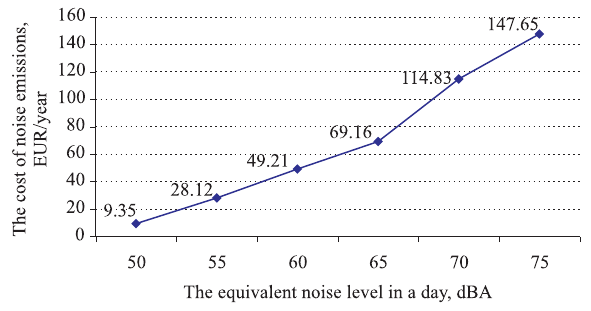
Fig. 7. Th e cost (EUR) of noise emissions per year (Accumulation and renewal of traffi c data of the roads of national signifi cance, 2008)